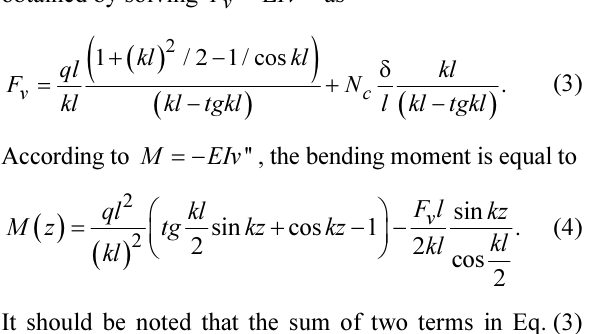
It should be noted that the sum of two terms in Eq.